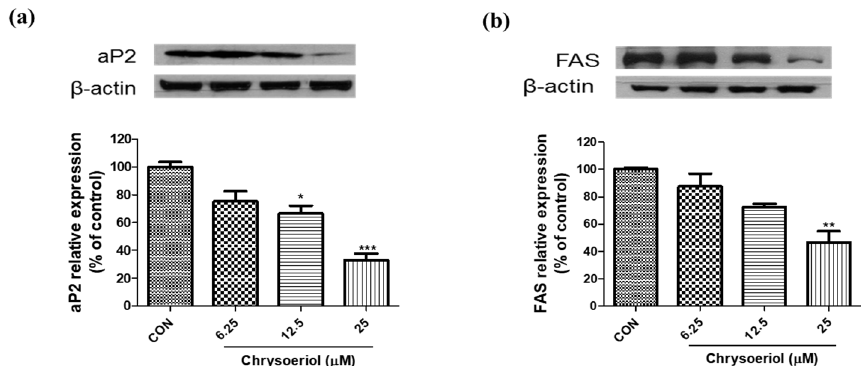
5 of 9 Figure 3. Effects of chrysoeriol on CEBP- α ( a ), C/EBP- β ( b ), SREBP1c ( c ) and PPAR γ ( d ) expression in 3T3-L1 adipocytes. *, **, *** p < 0.05, 0.01, and 0.001, respectively, significant difference compared with control group. CON, control (differentiated cells). Then, we investigated whether chrysoeriol inhibits the expression of late adipocyte markers such as FAS and aP2 in adipocytes. The results showed that chrysoeriol signifi- cantly suppressed aP2 and FAS protein expression compared to that in control cells (Fig- ure 4). The genes encoding aP2 and FAS are late differentiation markers of adipocytes and play a pivotal role in the signaling pathway related to obesity. aP2 plays a key role in obesity associated with fatty acid metabolism, and the inhibition of aP2 expression is linked to the decreased utilization of fatty acids [27]. FAS, a lipogenic enzyme, regulates triglyceride synthesis and storage of triglycerides [28]. Meanwhile, it is well-known that chrysoeriol is the main methylation metabolite of luteolin in vivo [29]. In a previous study,